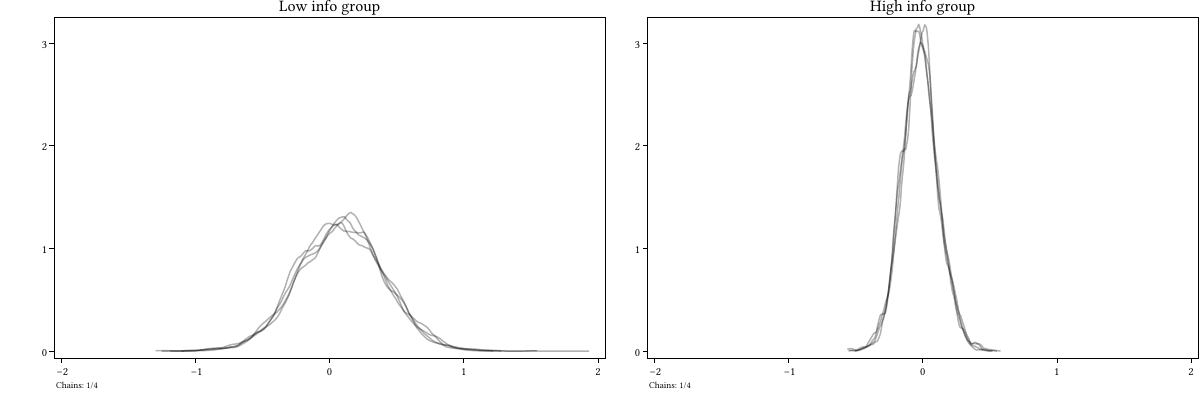
Figure 3. How awareness of the extreme asks influences response to the market price. Table 7. β ’s sensitivity to considering extreme asks. Experimental Group H Odds Ratio Result Low Info H A 1.5 Inconclusive High Info H A 1.3